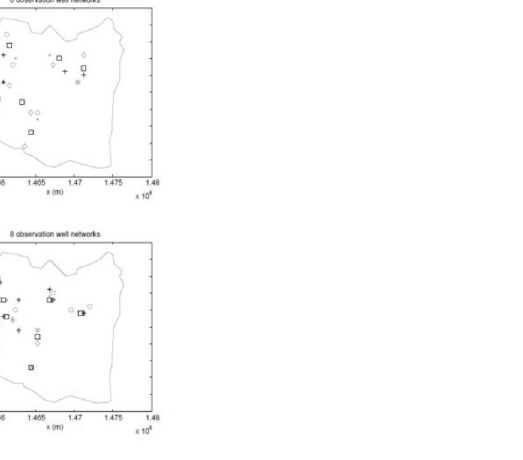
Fig 14. Five-, six-, seven-, and eight-well designs.